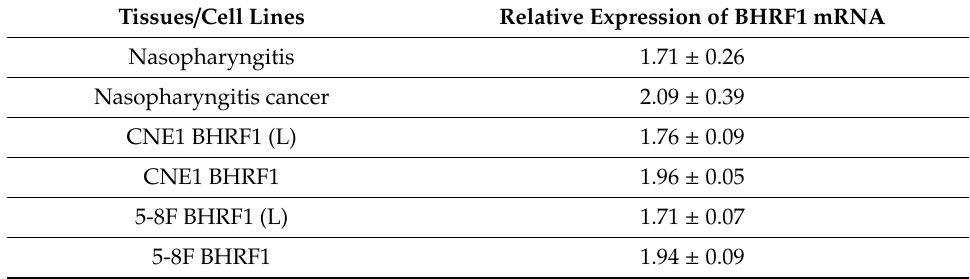
Figure 2. The high expression of BHRF1 in NPC cells alters mitochondrial morphology. ( A ), Western blot analysis of BHRF1 expression from the cell lysates of independent clones of CNE1 (CNE1 BHRF1(L, for low expression) and CNE1 BHRF1) and 5-8F (5-8F BHRF1(L) and 5-8F BHRF1) cells using anti-Flag antibody (1:1000 dilution). ( B ), Mitochondria in NPC cells observed under transmission electron microscopy. ( C ), Fifty mitochondria were randomly selected from three images to each cell line to measure their sizes. The p value was evaluated by a paired t -test. Image J was uesd to measure mitochondria area on TEM micrographs. Table 2. Relative BHRF1 mRNA expression between high BHRF1 expression NPC cell lines and patient